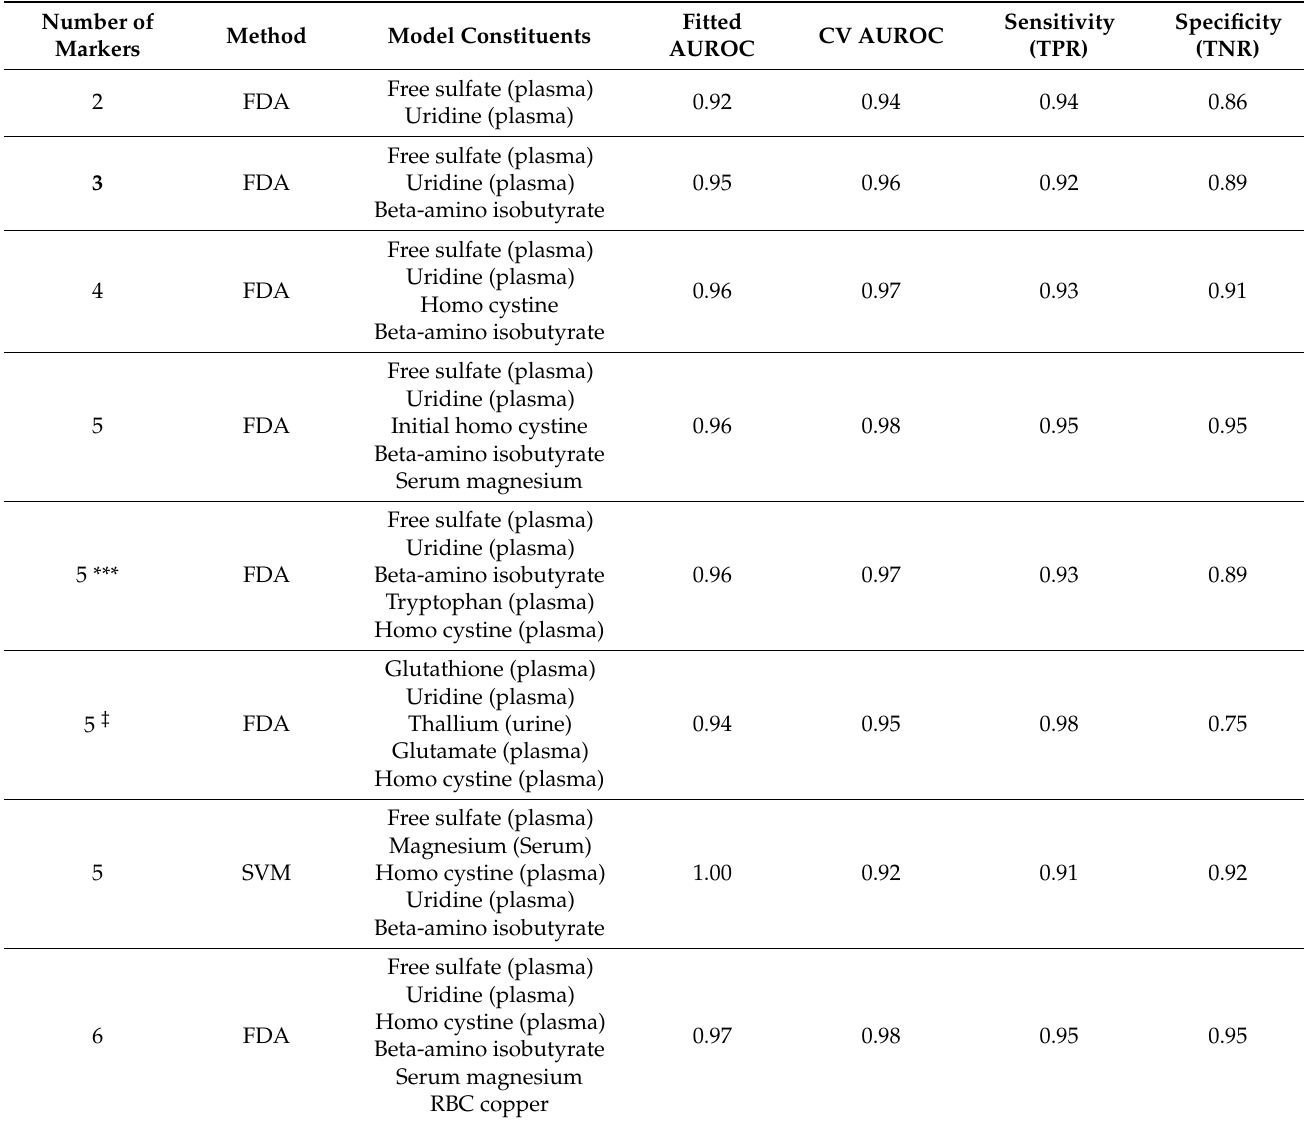
Table 2. FDA and SVM models that achieved the highest AUROC following cross-validation (CV) for each number of potential biomarkers. CV AUROC was calculated by using leave-one-out cross- validation and performing multiple imputations when needed (except in the *** model). Sensitivity and specificity are provided for the optimal operating point of the CV ROC